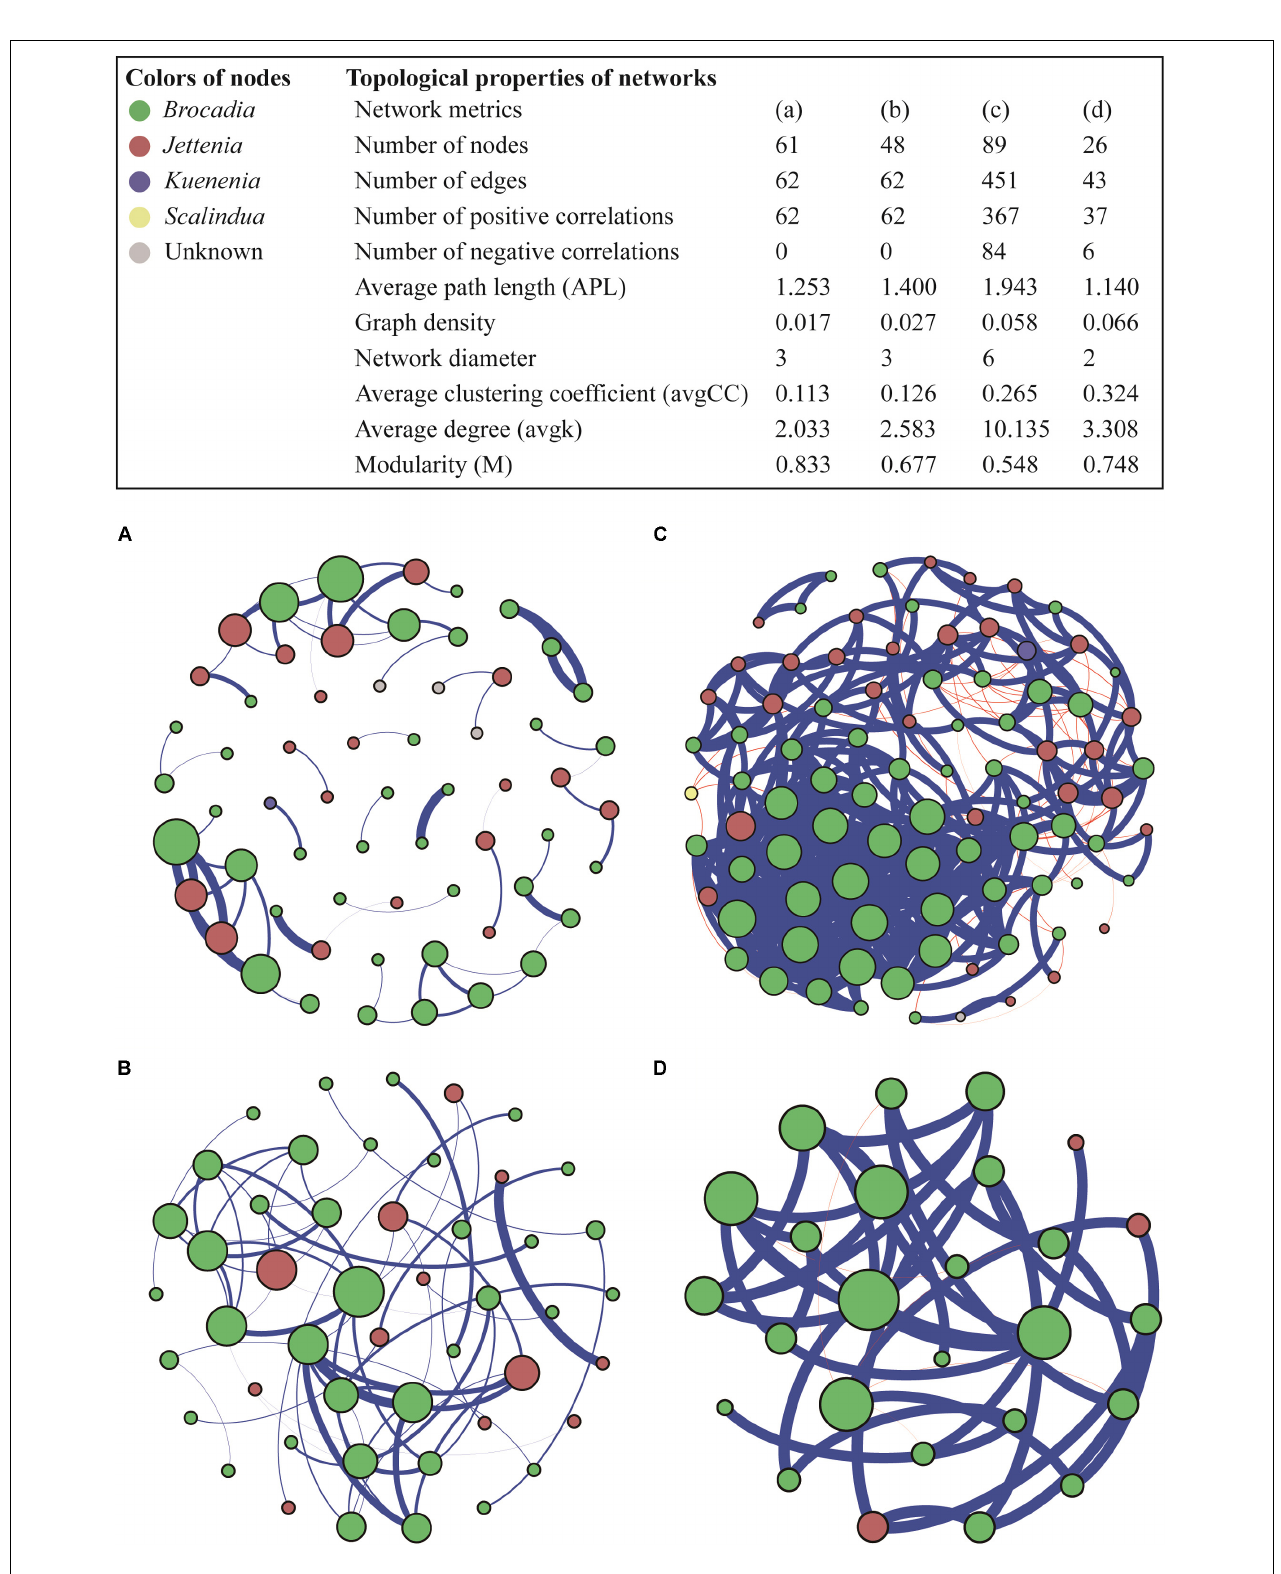
FIGURE 5 | Ecological networks of co-occurring anammox bacterial OTUs in drylands (A) , wetlands (B) , groundwater aquifers (C) and snow (D) , based on correlations. A connection corresponds to a strong (Spearman’s ρ > 0.8) and significant ( P < 0.05) correlation. The size of each node is proportional to the number of connections (i.e., degree); the thickness of each connection between two nodes (i.e., edge) is proportional to the value of Spearman’s correlation coefficients. A blue edge indicates a positive interaction between two individual nodes, while a red edge indicates a negative interaction.